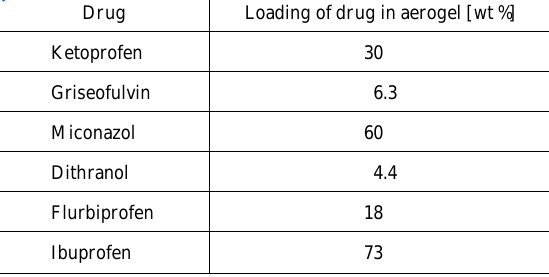
Table 1 Loading of hydrophilic aerogels from saturated solutions in CO